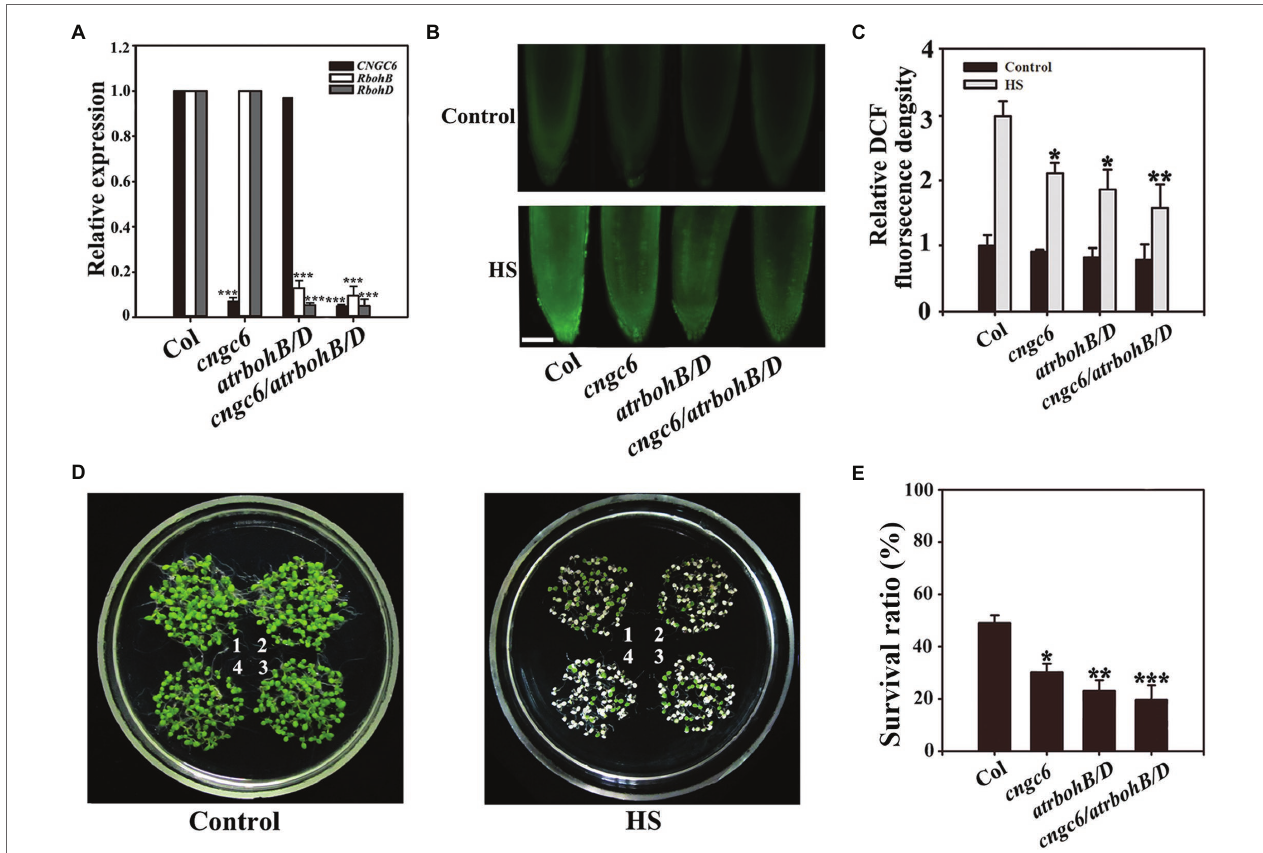
FIGURE 5 | Survival status of the cngc6/rbohB/D triple mutant. (A) RT-qPCR analysis of cyclic nucleotide-gated ion channel 6 ( CNGC6 ), RbohB and RbohD transcription in wild-type, cngc6 , rbohB/D , and cngc6/rbohB/D seedlings. The experiments were repeated three times with similar results. Each data point represents the mean ± SD ( n = 3). Asterisks indicate a significant difference relative to Col; *** p < 0.001 (Student’s t -test). (B) About 8-day-old wild-type, cngc6 , rbohB/D , and cngc6/rbohB/D seedlings grown at 22 ° C were exposed to 45 ° C (HS) or maintained at 22 ° C (Control) for 30 min. The H 2 O 2 levels in the seedlings were then examined by fluorescence microscopy using roots stained with CM-H 2 DCFDA. Bar = 100 μ m. (C) Relative DCF fluorescence densities in the roots. The data presented are the means ± SE of measurements taken from five independent experiments with at least 10 roots for each treatment. * p < 0.05, and ** p < 0.01 vs. Col (Student’s t -test). (D) About 8-day-old seedlings grown at 22 ° C were exposed to 45 ° C (HS) or maintained at 22 ° C (Control) for 100 min, then returned to 22 ° C and photographed 5 days later. The clusters are as follows: 1, wild-type; 2, cngc6 ; 3, rbohB/D ; and 4, cngc6/rbohB/D . (E) Survival ratios of the seedlings after HS treatment. The data presented are the means ± SE of at least five independent experiments with 50 seedlings per experiment. * p < 0.05 and ** p < 0.01 vs. Col (Student’s t